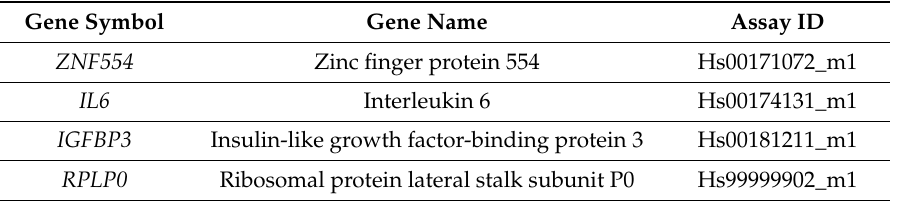
Table 2. TaqMan assays used for qRT-PCR expression